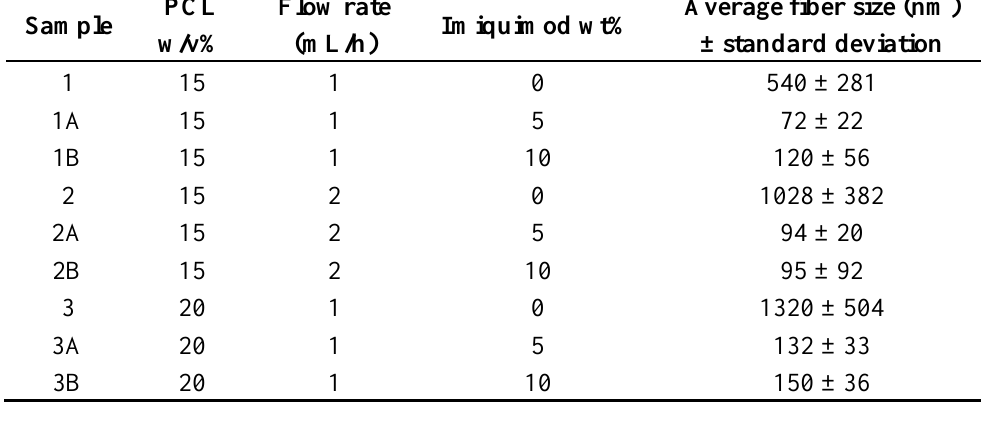
Table 2. Electrospinning variables and fiber size analysis of PCL/Imiquimod nanofibers.